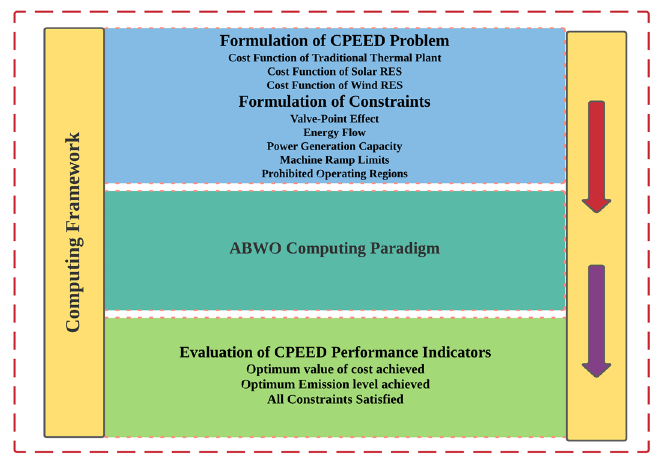
Figure 2. Computing framework of proposed CPEED.